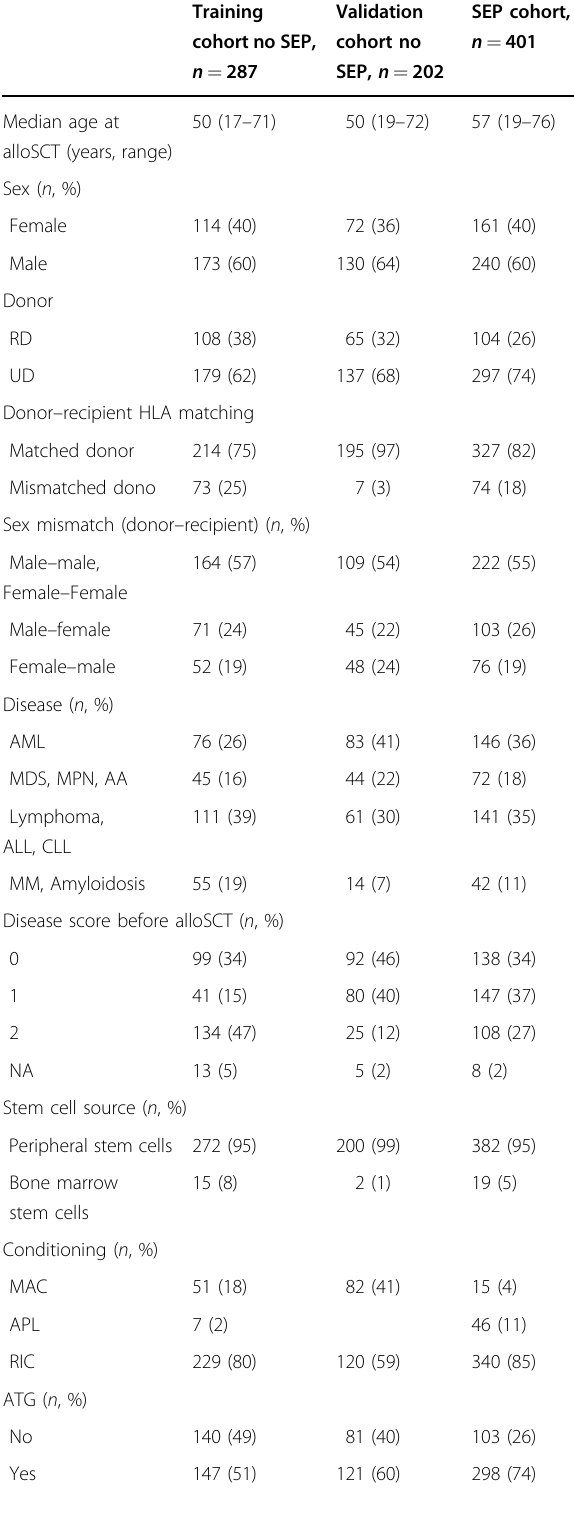
Table 1 Patient characteristics in the training cohort, validation cohort, and SEP